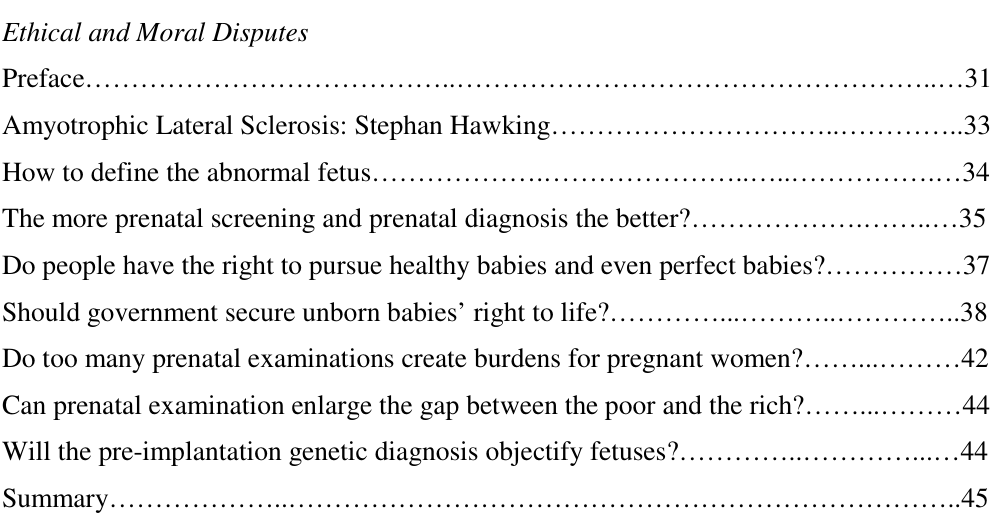
Ethical and Moral Disputes